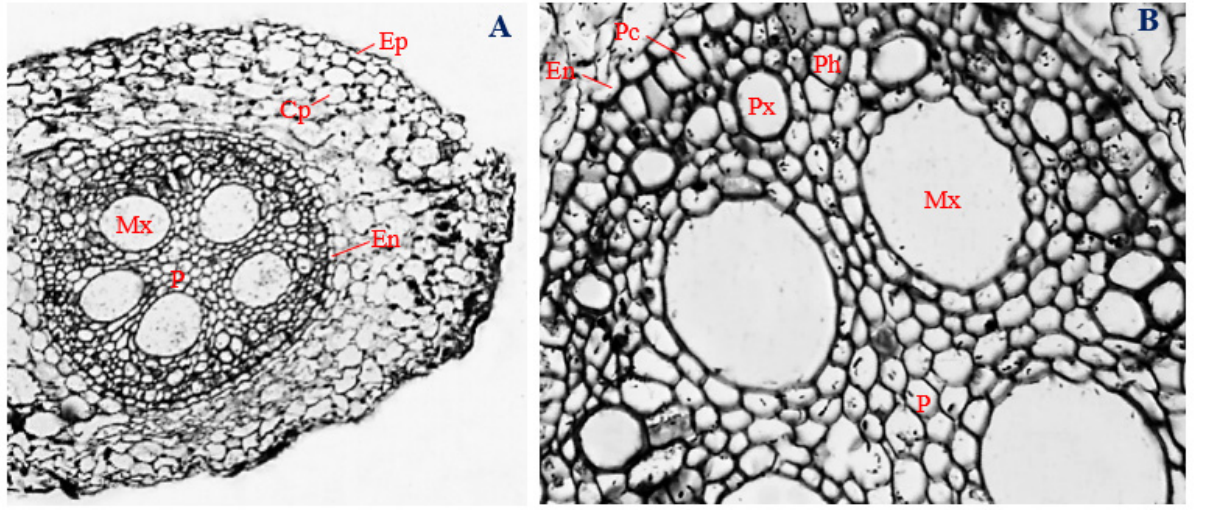
Figure 3. The transverse section of corn roots infected with endophytic Fusarium sacchari. ( A ) Mag- Figure nification 40×; ( B ) magnification 200×. Ep, epidermis; Cp, cortical parenchyma; En, Endodermis; Pc, pericycle; Px, protoxylem; Ph, phloem; Mx, metaxylem; and P, pith.